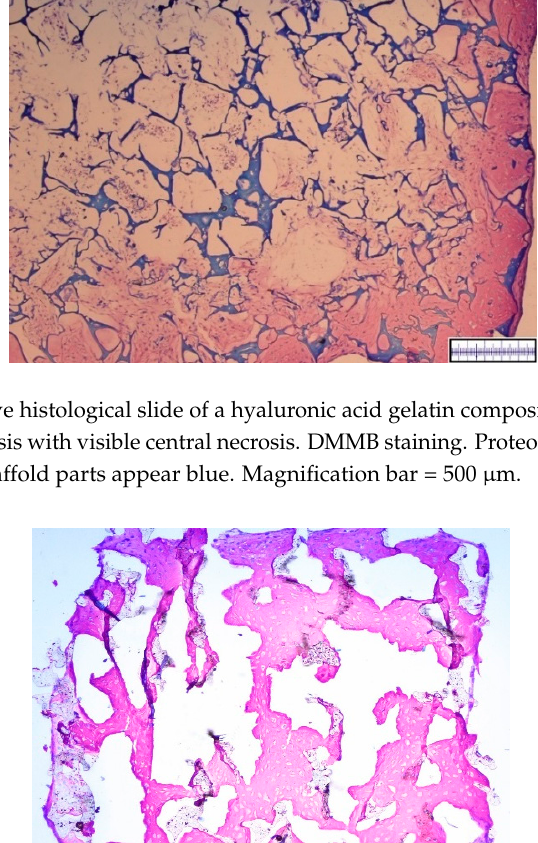
Figure 6. Representative histological slide of an Actifit ® scaffold after 21 days of in vitro chondrogenesis. DMMB staining. Proteoglycan-rich extracellular matrix appears red, scaffold parts appear grey and porous. Magnification bar = 500 μ m.